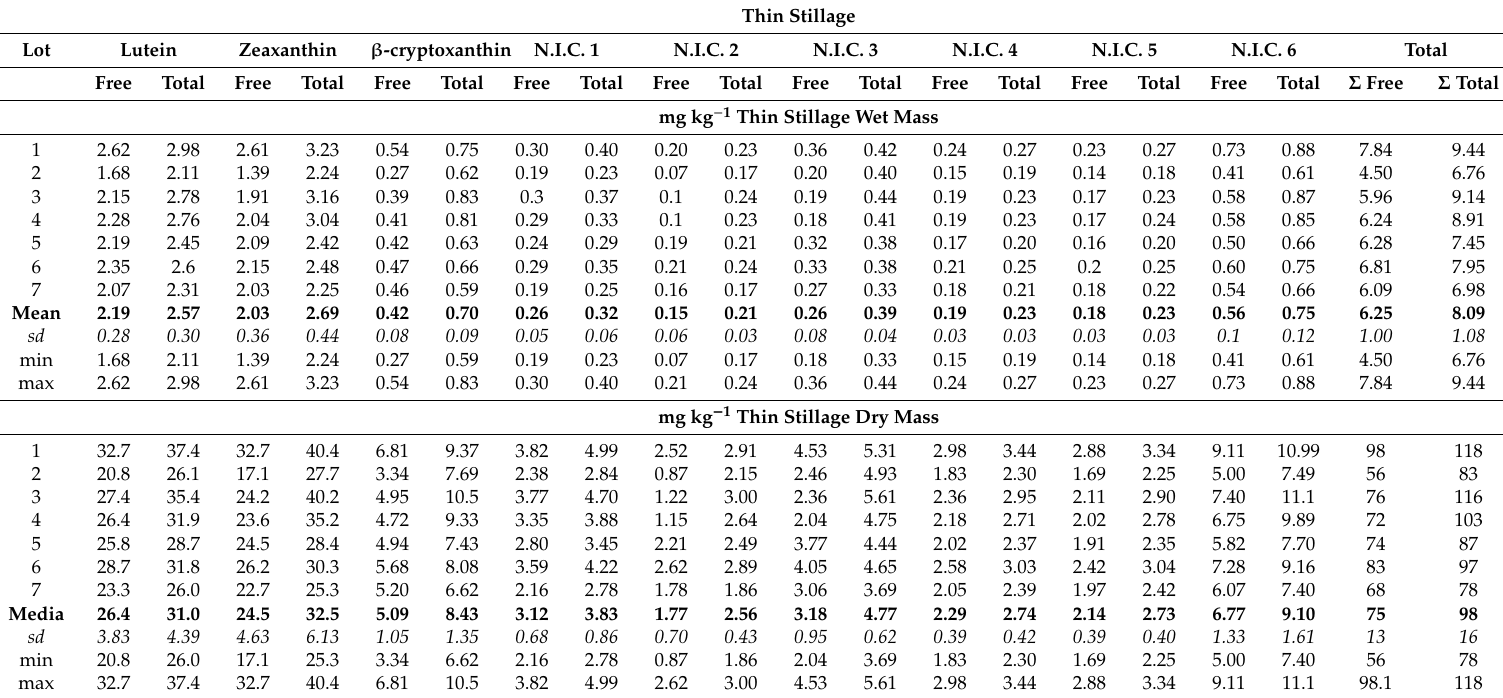
Table 6. Free and total amounts of carotenoids in thin stillage from a dry-grind corn ethanol plant. Data refer to individual lots collected at monthly intervals from July 2018 to April 2019 and overall mean, standard deviation ( sd ), and range of values observed ( n = 7)